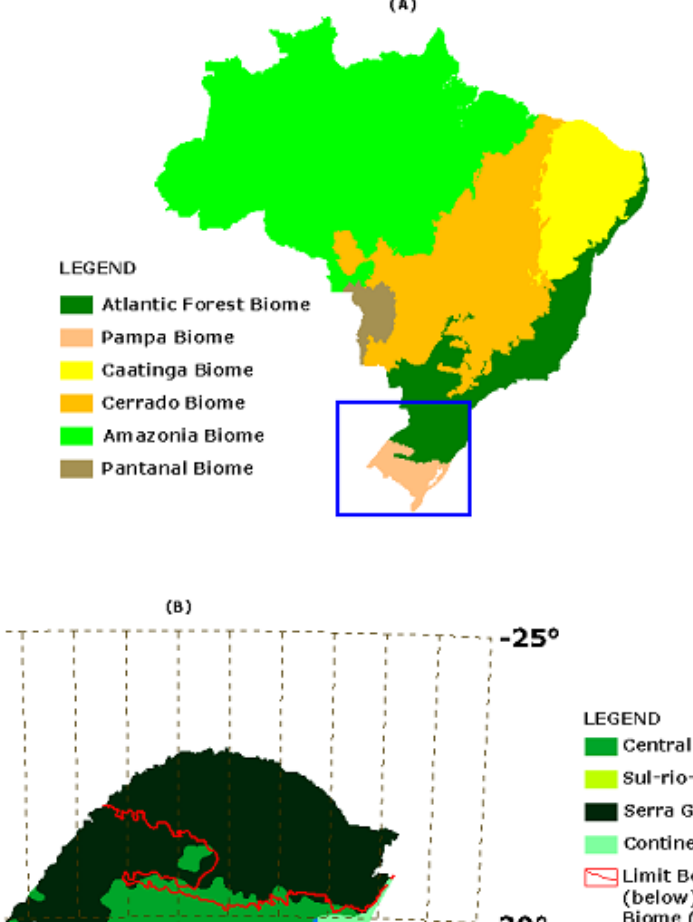
Figure 1. (a) The six terrestrial biomes according to the official Brazilian classification [12]. (b) Map of Rio Grande do Sul State showing the four geological provinces and the limit of the Brazilian Pampa